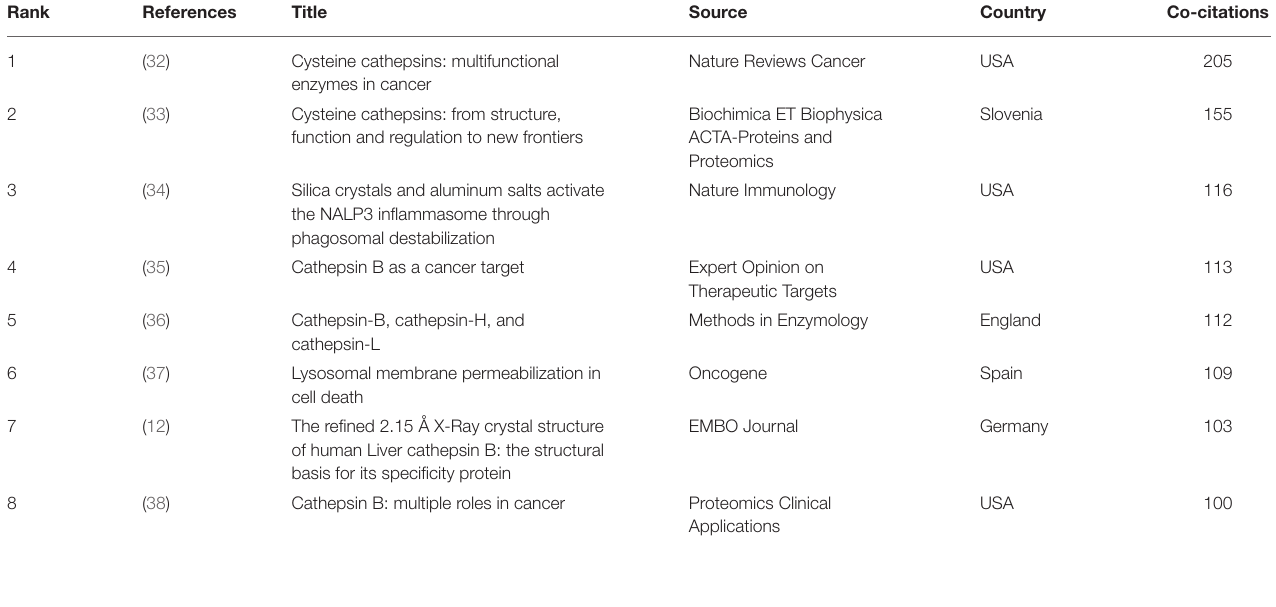
TABLE 2 | Top eight co-citation analysis of references on CTSB research.